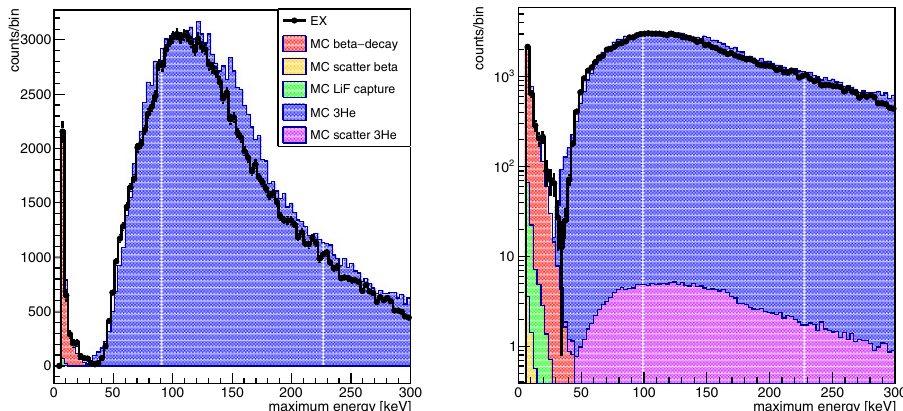
Figure 6. Monte-Carlo simulated distributions of energy deposits sensed by the field wires for the different processes in a linear scale (Left) and a logarithmic scale (Right), together with the experimental data shown as black dots. One can see a clear separation of the beta-decay events from the 3 He( n , p ) 3 H reaction events. The threshold is set at 25keV. The “scatter beta” denotes neutron beta-decays after scattering by the TPC gas, and the “scatter 3He” denotes captures of scattered neutrons by 3 He. The events denoted by “LiF capture” are due to ionization by γ -rays emitted after neutron capture in the LiF plates.